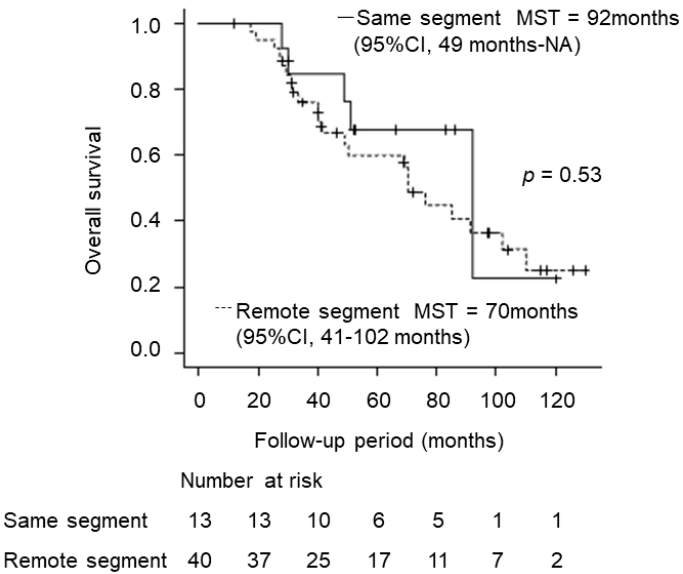
Figure 5. Overall survival (OS) for same-segment and remote-segment groups. Median OS for the same-segment group was 92 months (95% CI, 49 months–NA), and that for the remote-segment group was 70 months (95%CI, 41–102 months), showing no significant difference ( p = 0.53). Figure 6 shows box-and-whisker plots for the transition of ALBI scores at 3, 6, and 12 months after irradiation. No significant difference in median ALBI score was seen between same- and remote-segment groups before irradiation. Likewise, no significant differences were apparent 3 months after irradiation. However, ALBI scores after 6 and 12 months were significantly different in the same-segment ( p = 0.015) and remote-segment ( p = 0.030) groups.